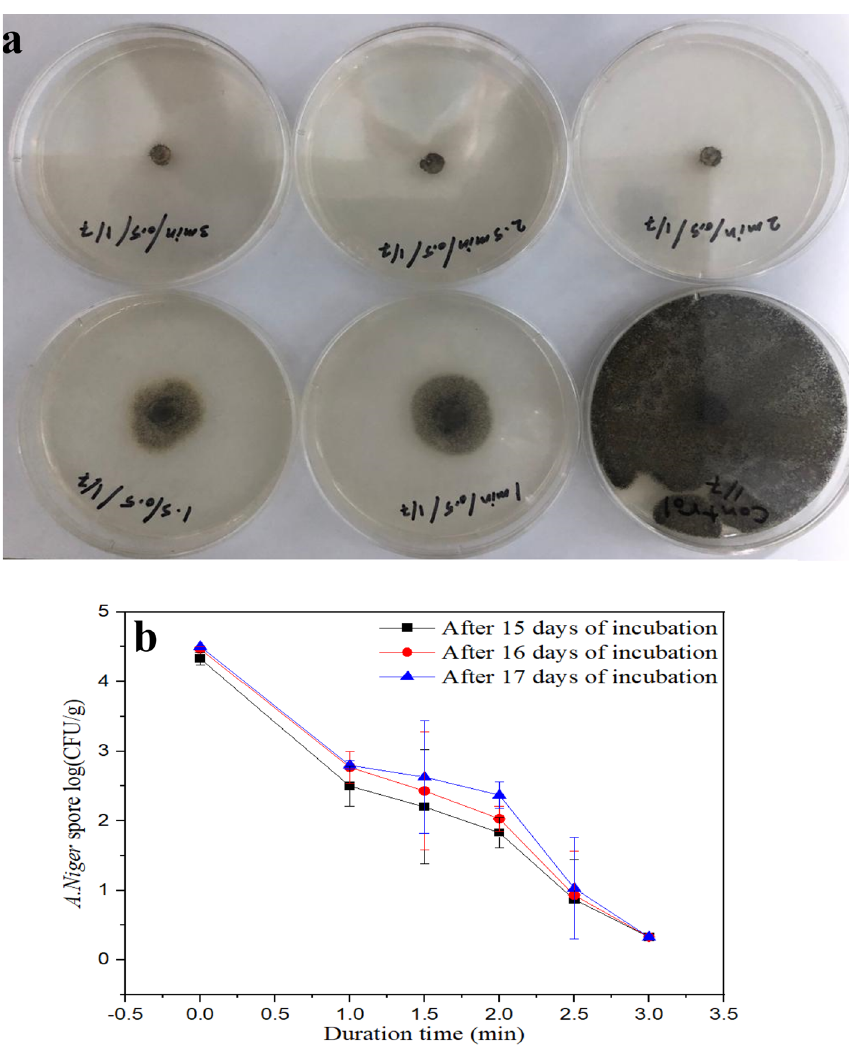
Figure 2. Inactivation of A. niger using SDBD at different treatment time; ( a ) A. niger spore after 2 days of incubation and ( b ) A. niger spore log 10 (CFU/g) after 15, 16 and 17 days of incubation, P value =